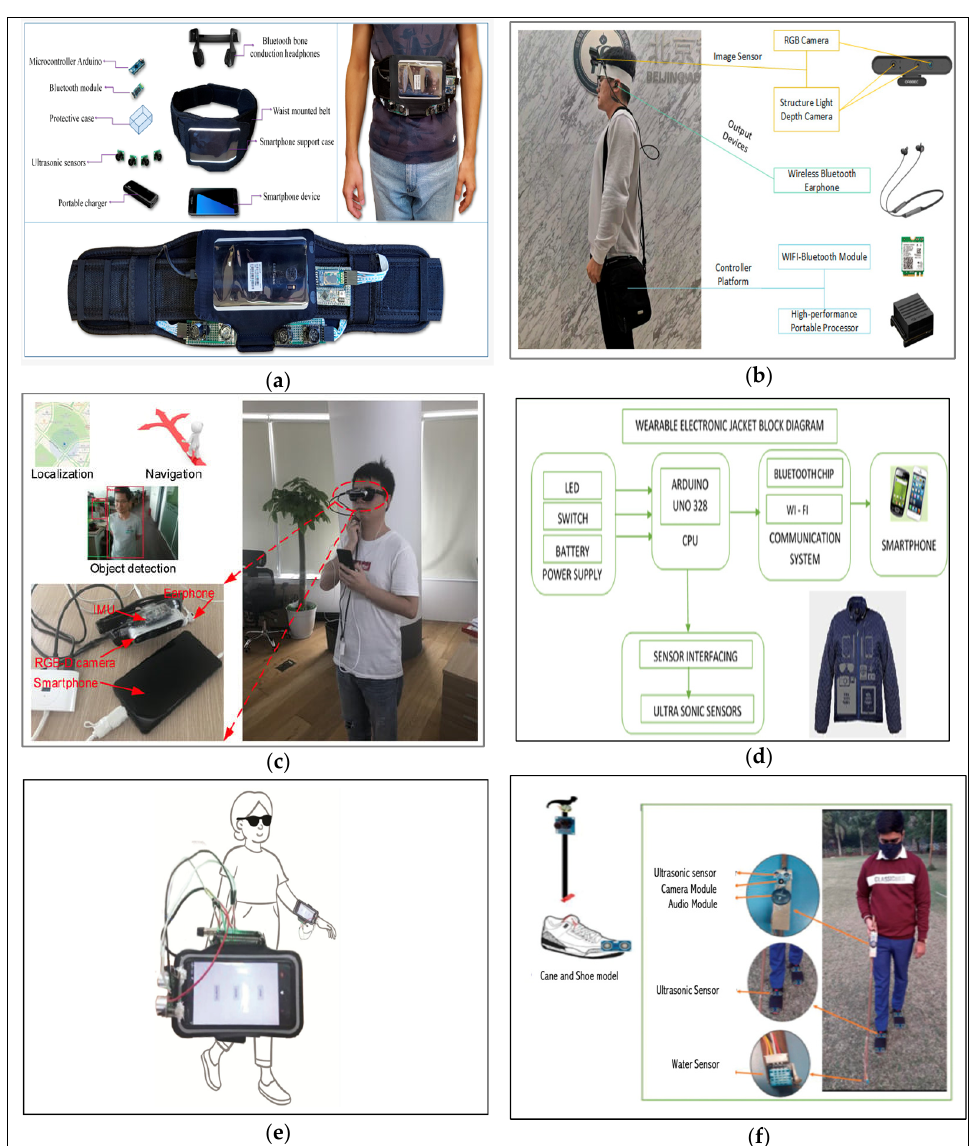
Figure 2. Illustration of some wearable assistive technologies with obstacle detection incorporated.